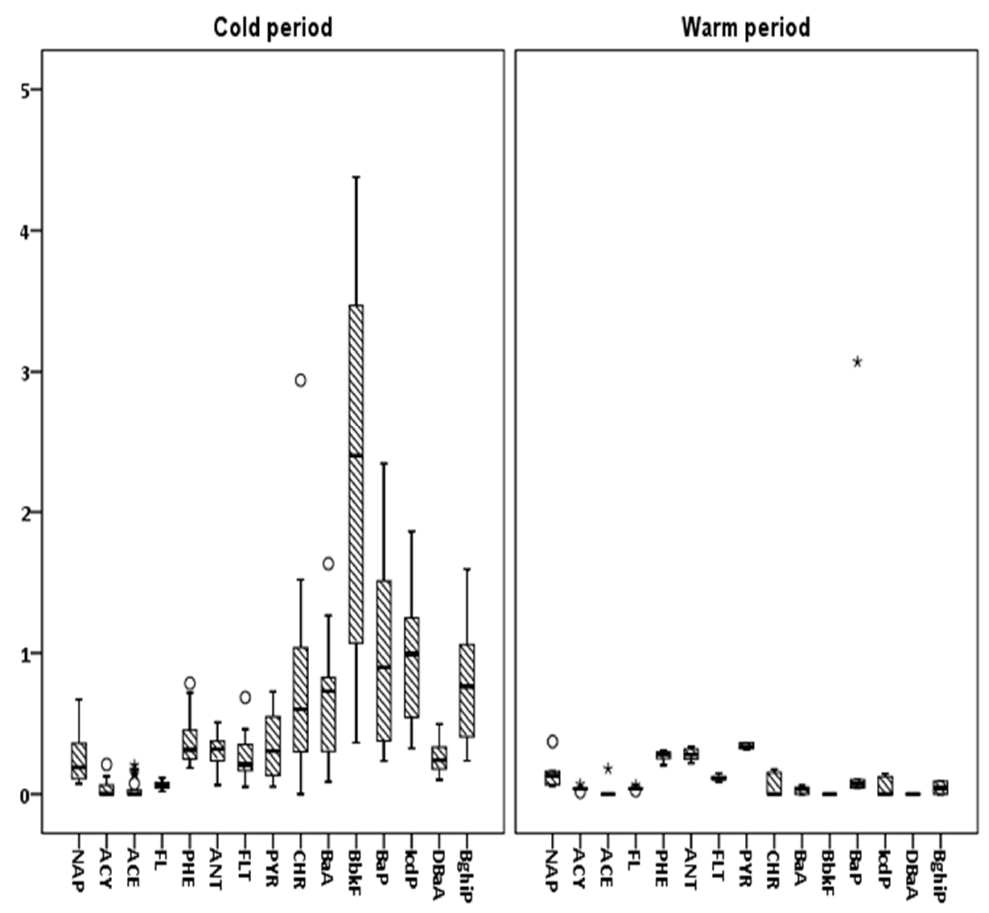
− 3 (* outliers and o values above 3rd